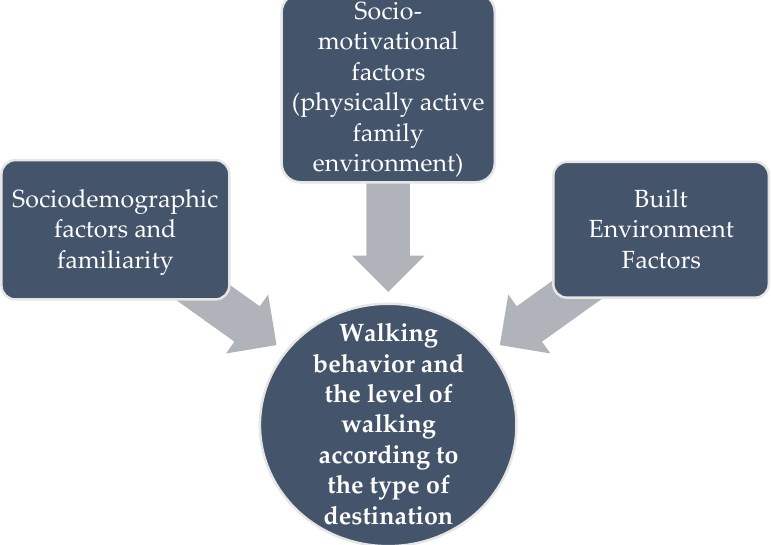
Figure 1. The Research Framework.